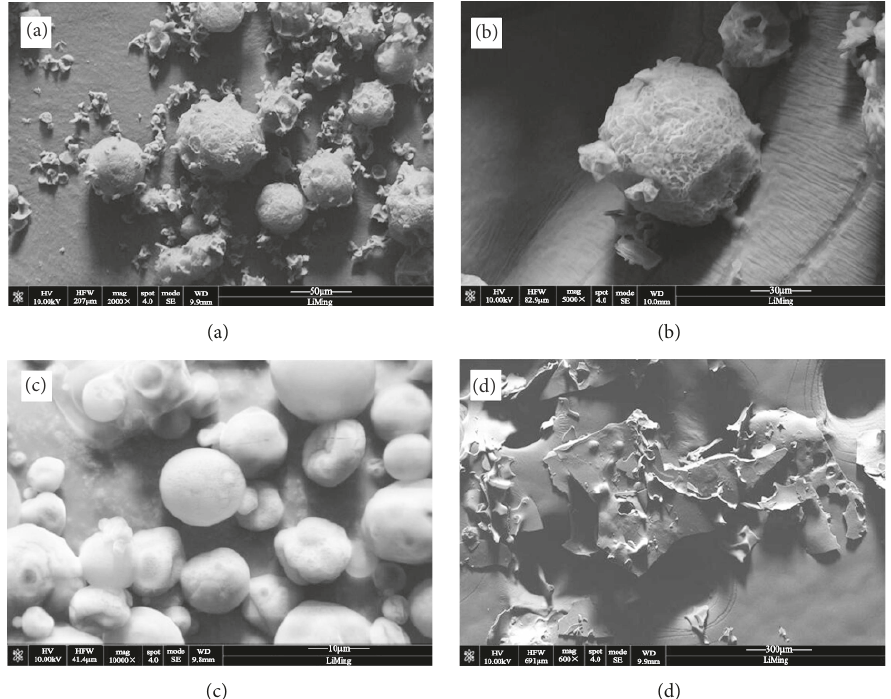
Figure 5: Comparison of the morphology of (a) spray-freeze-dried (2000x); (b) spray-freeze-dried (5000x); (c) spray-dried (10000x); and (d) freeze-dried (600x) fish oil